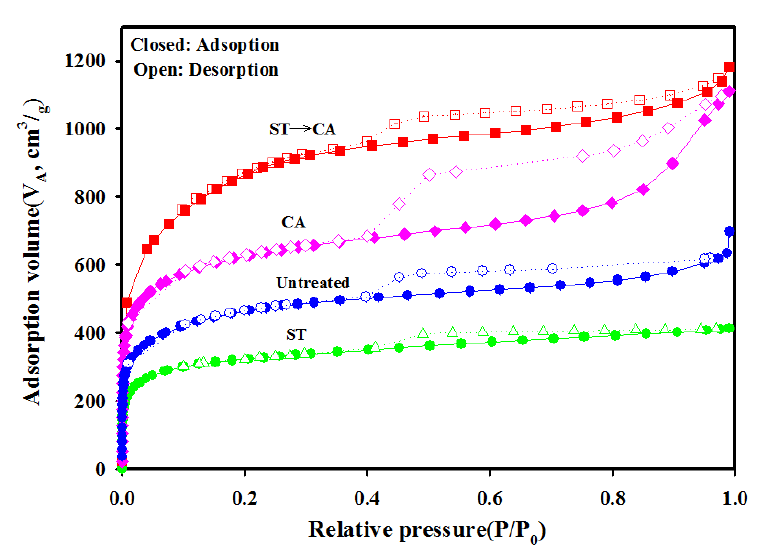
Figure 5. Isothermal Ar adsorption–desorption curves of ACFs (Untreated, untreated ACFs; ST, ACFs prepared through surface treatment for 80 min; CA, ACFs prepared through chemical activation without prior surface treatment; ST → CA, ACFs prepared through chemical activation after surface treatment for 80 min).